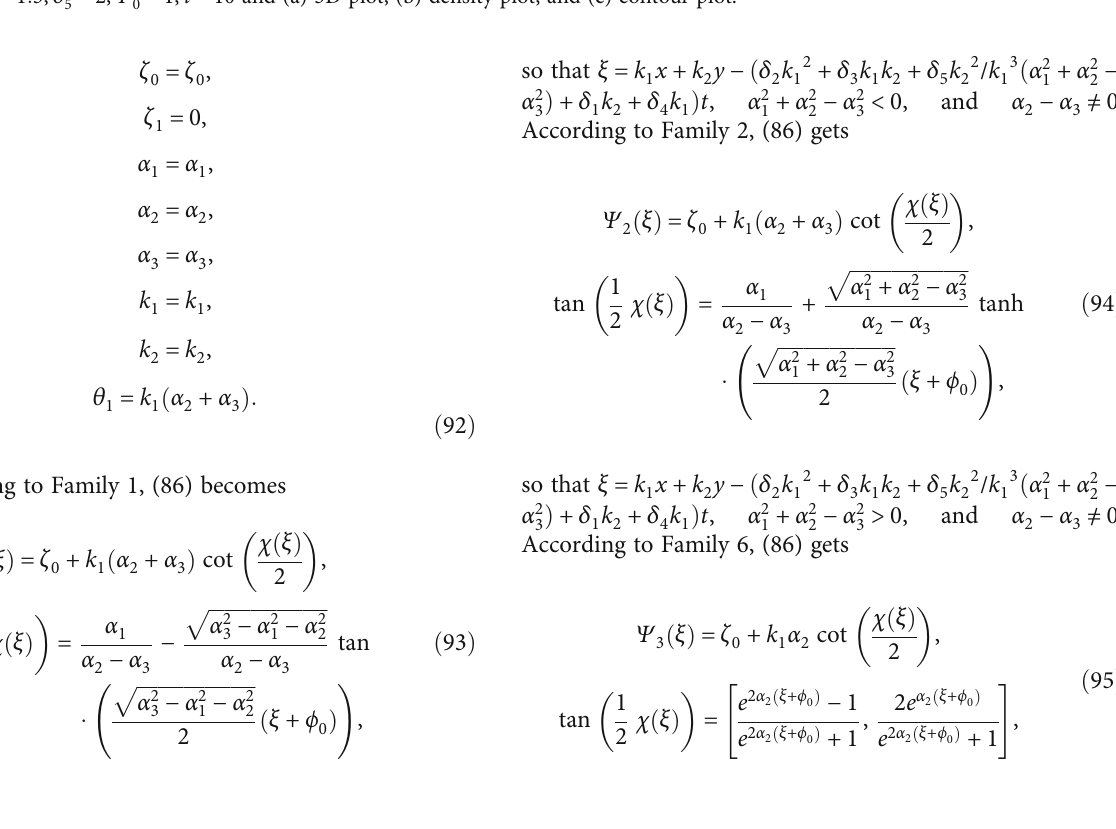
Figure 14: Plot evolution of cross-kink waves (53) utilizing values a = 2, δ = 1 : 3, δ = 2, Ψ = 1, t = 10 and (a) 3D plot, (b) density plot, and (c) contour 1 : 3, δ 3 4 5 0